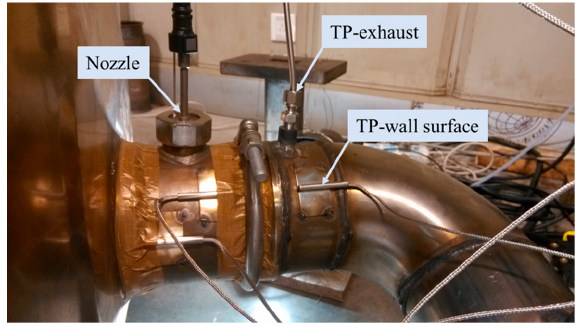
Figure 10. Layout diagram of the temperature sensors.